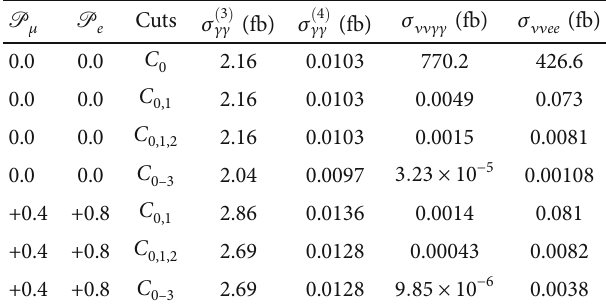
Table 5: Cumulative e ff ects of the cuts (17) on the cross sections for (14), (15), and (16) at E = 100 GeV, E μ = 3 e